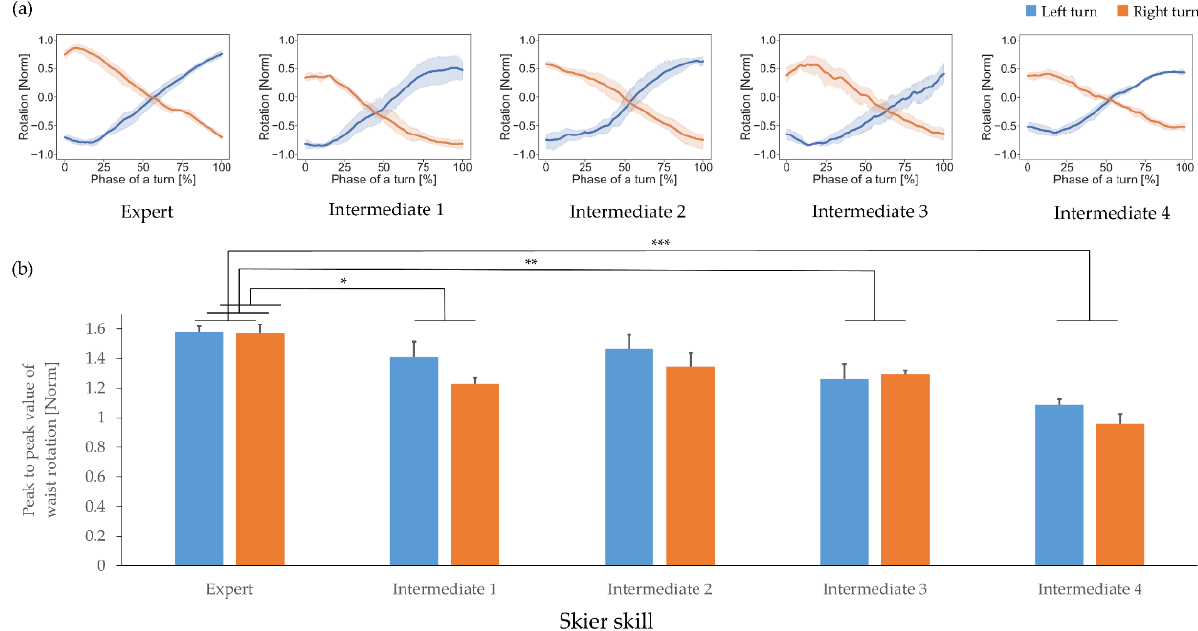
Figure 7. ( a ) Waist rotation for each participant, and ( b ) the quantitative feature representing waist rotation. Blue and orange represent the left and right turns, respectively. Statistical significance is indicated with * p < 0.05, ** p < 0.01, *** p < 0.001. Table 2. Results of the post-hoc comparisons for the quantitative waist rotation feature. The expert skier was compared to each intermediate skier.